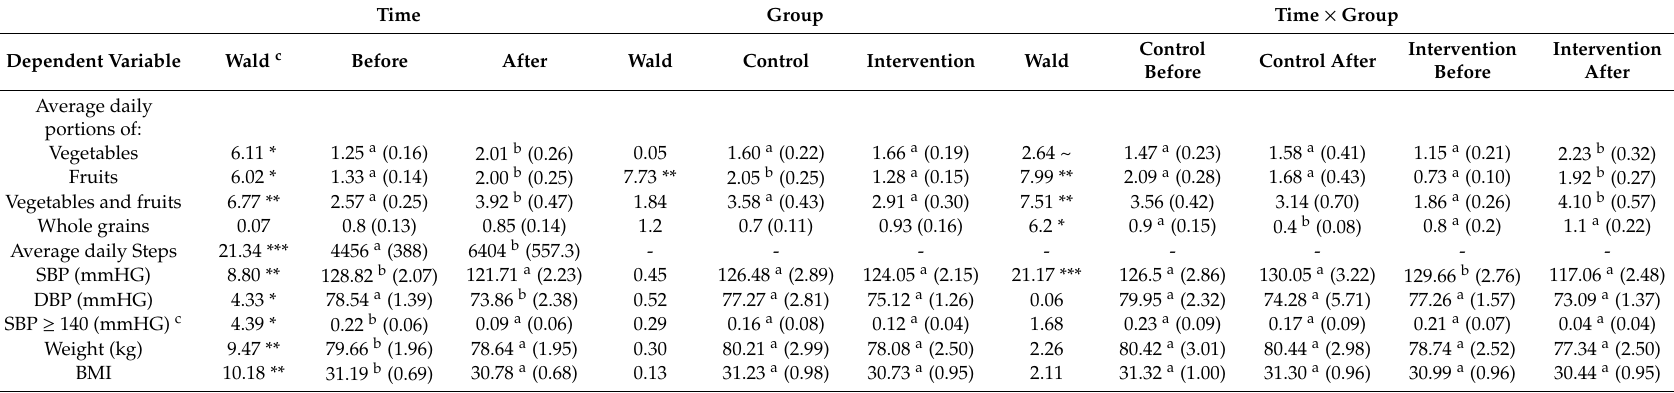
Table 2. Generalized Estimating Equations (GEE) regression analysis for di ff erences in outcomes between baseline and six months for the quasi-experiment. Time Group Time × Group Dependent Variable Wald c Before After Wald Control Intervention Wald